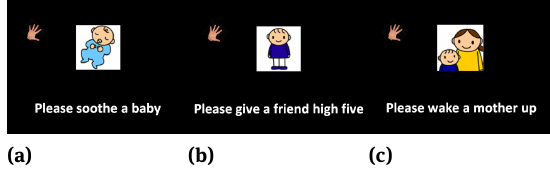
The Touch Ball was connected to a PC computer as shown in Figure 5. On that figure, f the signals from the three-component force sensor.